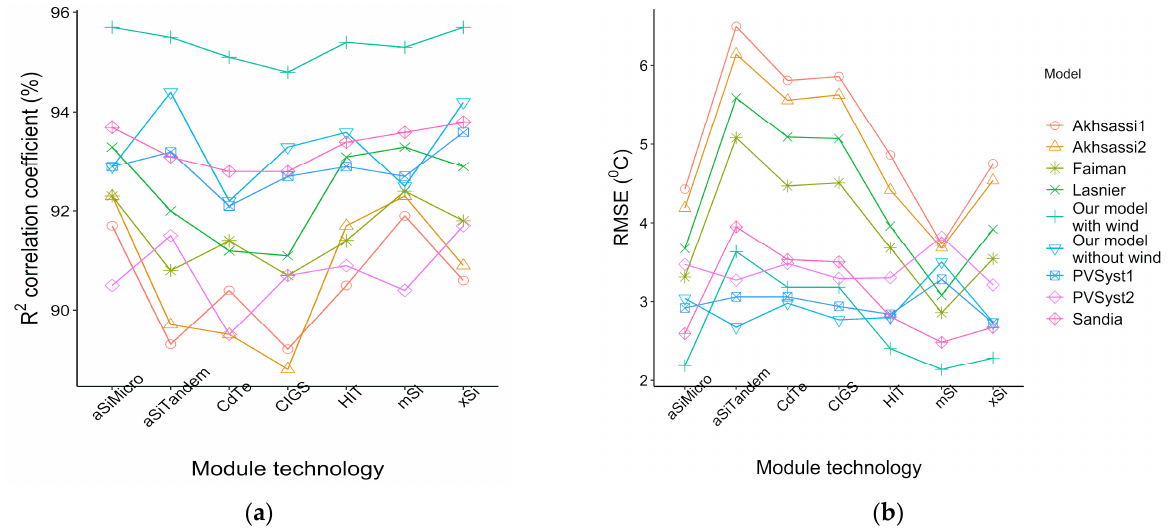
Figure 5. Correlation between measured and calculated module temperature for different module technologies obtained with the studied models for Cocoa, USA: ( a ) correlation factor R 2 ; ( b ) RMSE